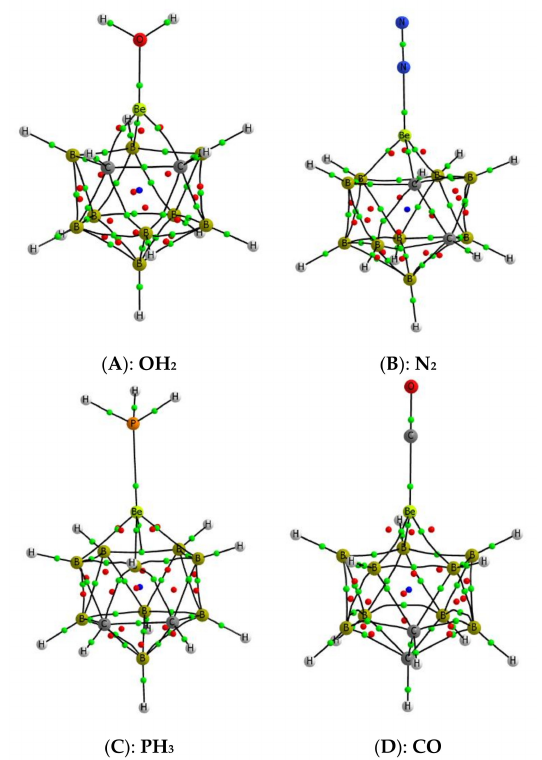
Figure 6. Molecular graph of some complexes. The location of the bond, ring, and cage critical points is indicated with green, red, and blue dots, respectively. A – D the same as in Figure